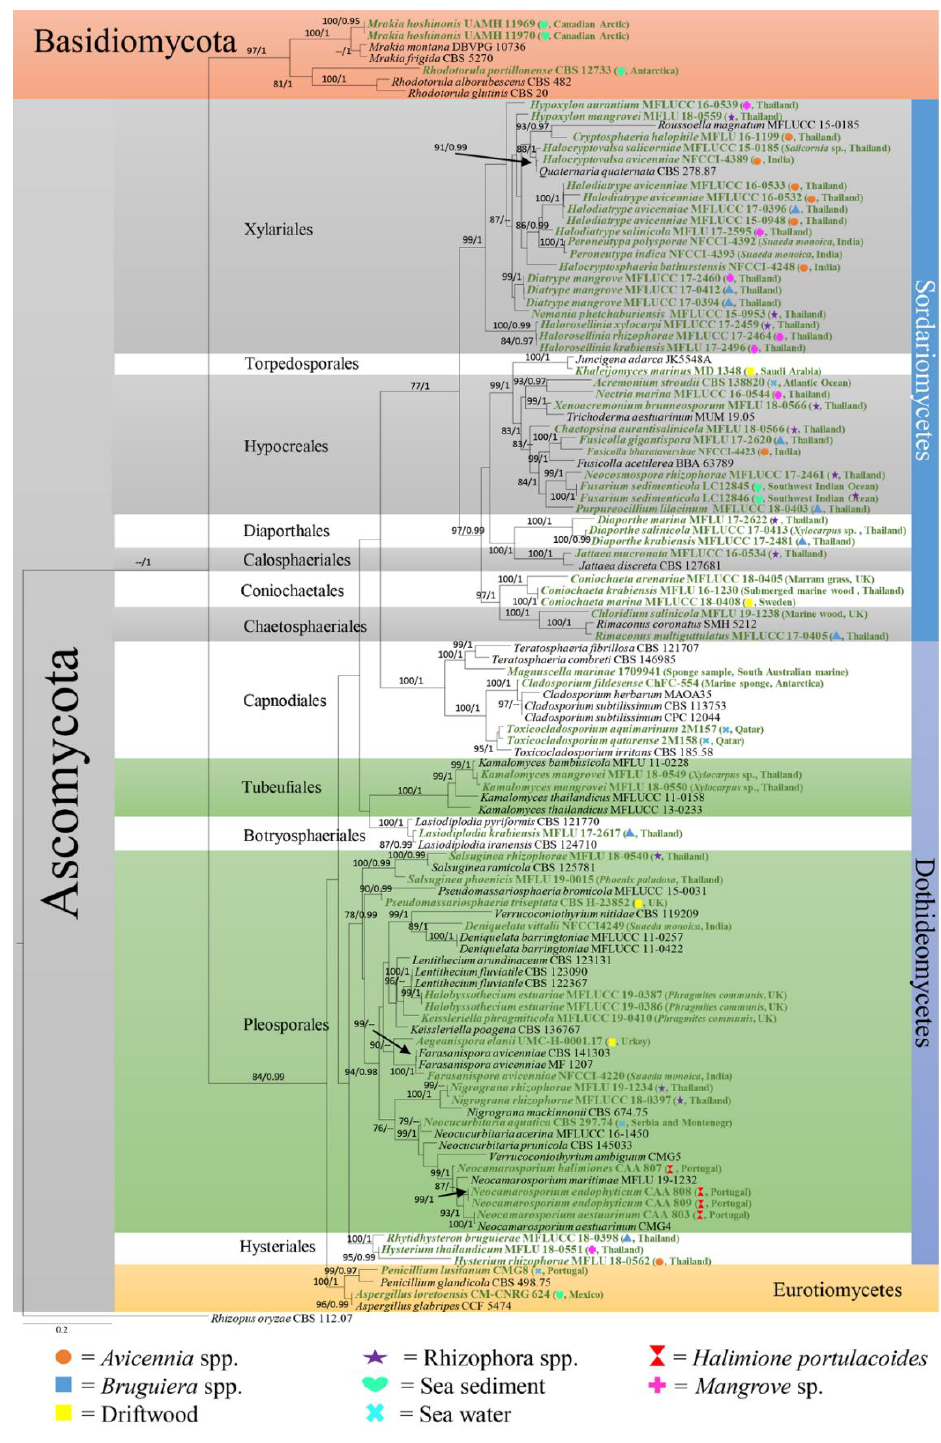
Figure 1. Maximum likelihood analysis with 1000 bootstrap replicates yielded the best tree with the likelihood value of − 40790.364548. The combined LSU, TEF , and ITS sequence datasets were used for analysis with Rhizopus oryzae (CBS 112.07) as the outgroup taxon. The matrix had 1782 distinct alignment patterns, with 76.28% undetermined characters or gaps. The estimated base frequencies were A = 0.242997, C = 0.241567, G = 0.277277, and T = 0.238159; the substitution rates were AC = 1.251989, AG = 2.190388, AT = 1.501627, CG = 1.053941, CT = 4.653615, and GT = 1.000000; and the gamma distribution shape parameter was α = 0.407873. The maximum likelihood bootstrap (ML) values were ≥75% and the Bayesian posterior probabilities (PP) ≥0.95% are given above/below the nodes. The scale bar indicates 0.07 changes. The marine fungi isolates are shown in green and bold.